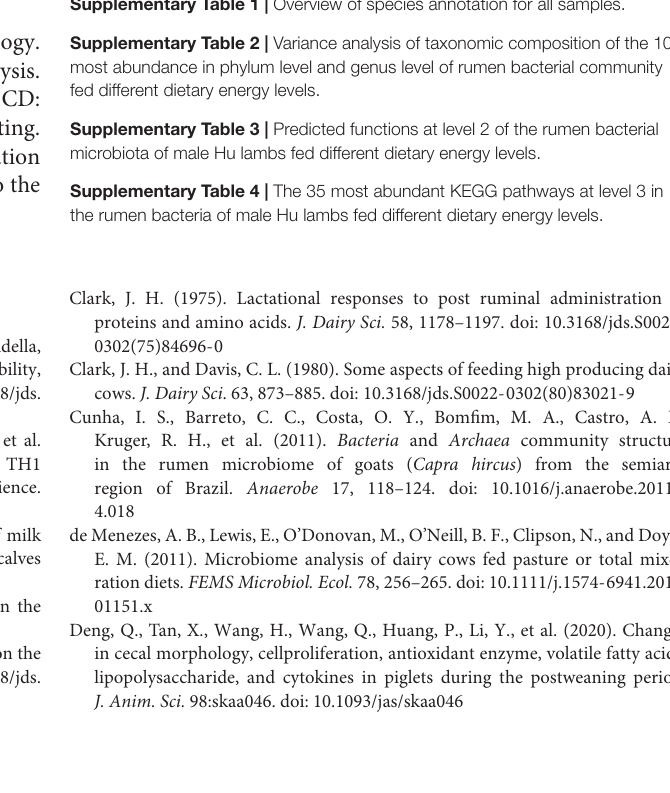
Supplementary Figure 1 | Rarefaction analyses of the different samples. Rarefaction curves of all samples and OTUs clustered at 97% similarity. Supplementary Figure 2 | NMDS analysis results based on OTU level from different dietary energy levels. Supplementary Figure 3 | The relative abundance of different functional taxa at level 1, annotated based on the KEGG orthologs datasets at different dietary nutrient levels. Supplementary Table 1 | Overview of species annotation for all